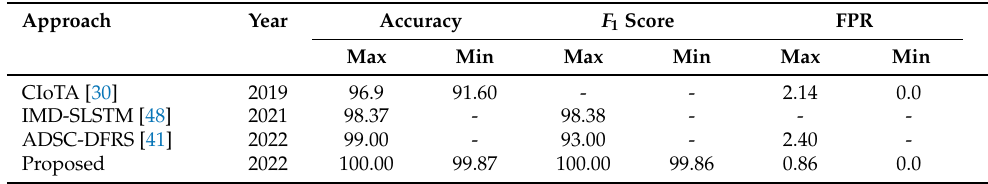
Table 5. Comparison of the performance with existing approaches, some performance metrics are not reported by all selected approaches and are therefore left blank.